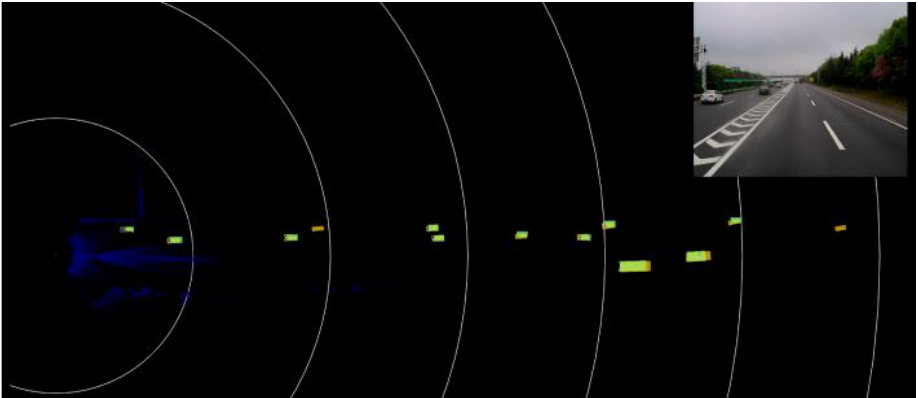
Figure 10. The Lidar ground Truth.